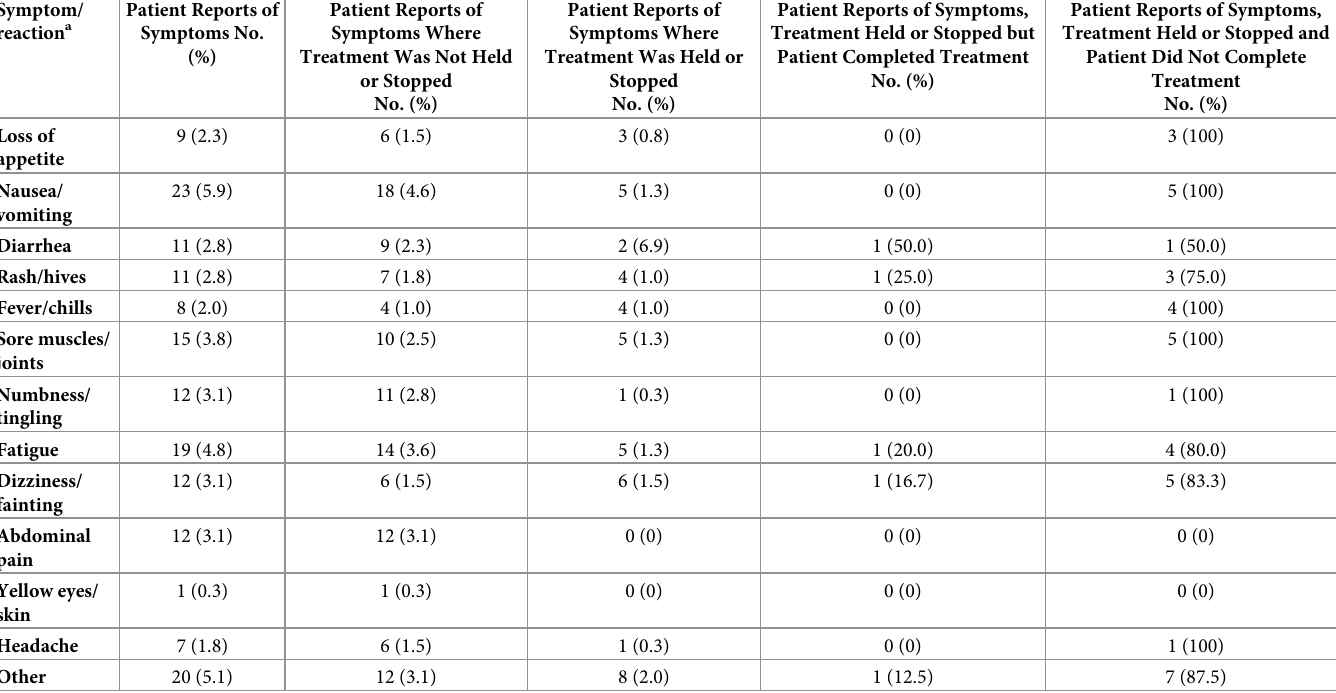
Table 2. Symptoms reported with a short-course regimen of 12 once-weekly directly observed doses of Rifapentine and Isoniazid (3HP) among persons experienc- ing homelessness in 11 program sites from July 2011- June 2015 (N = 393). Symptom/ Patient Reports of Symptoms reaction a